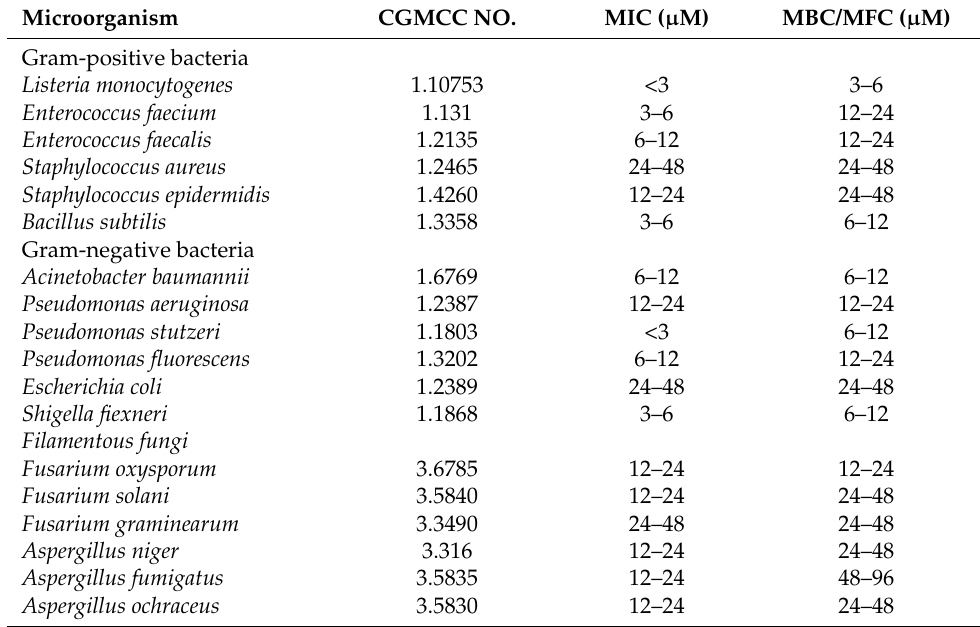
Table 2. Antimicrobial activity of